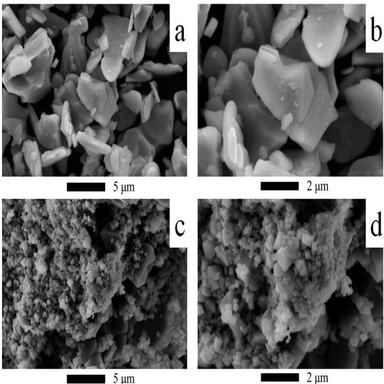
SEM images of (a, b) S-LCMO1 and (c, d) F-LCMO.